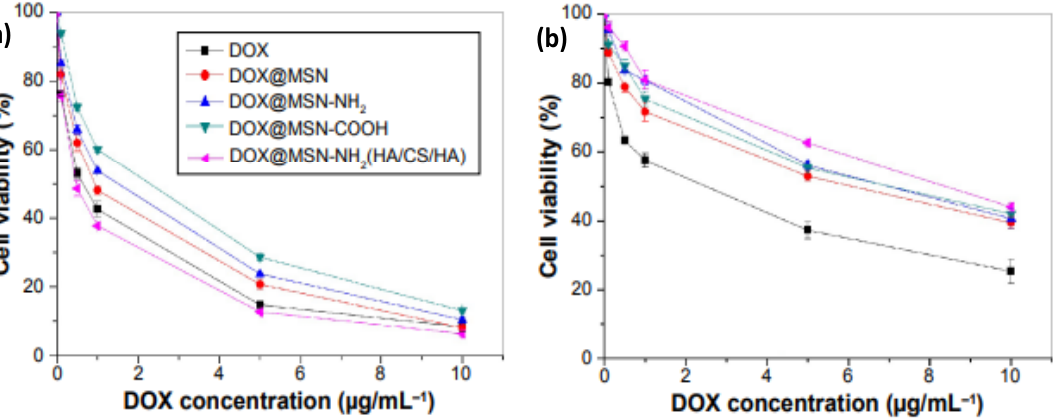
Figure 7. In vitro cytotoxicity assay curves of DOX, DOX@MSN, DOX@MSN-NH2, DOX@MSN- COOH, and DOX@MSN-NH2 (HA/CS/HA) on HepG2 ( a ) and L02 cells ( b ). Nomenclature: DOX: doxorubicin; CS: chitosan; HA: hyaluronic acid; MSN: mesoporous silica nanoparticle. Adapted from [46], with permission from Dove Medical Press Ltd.